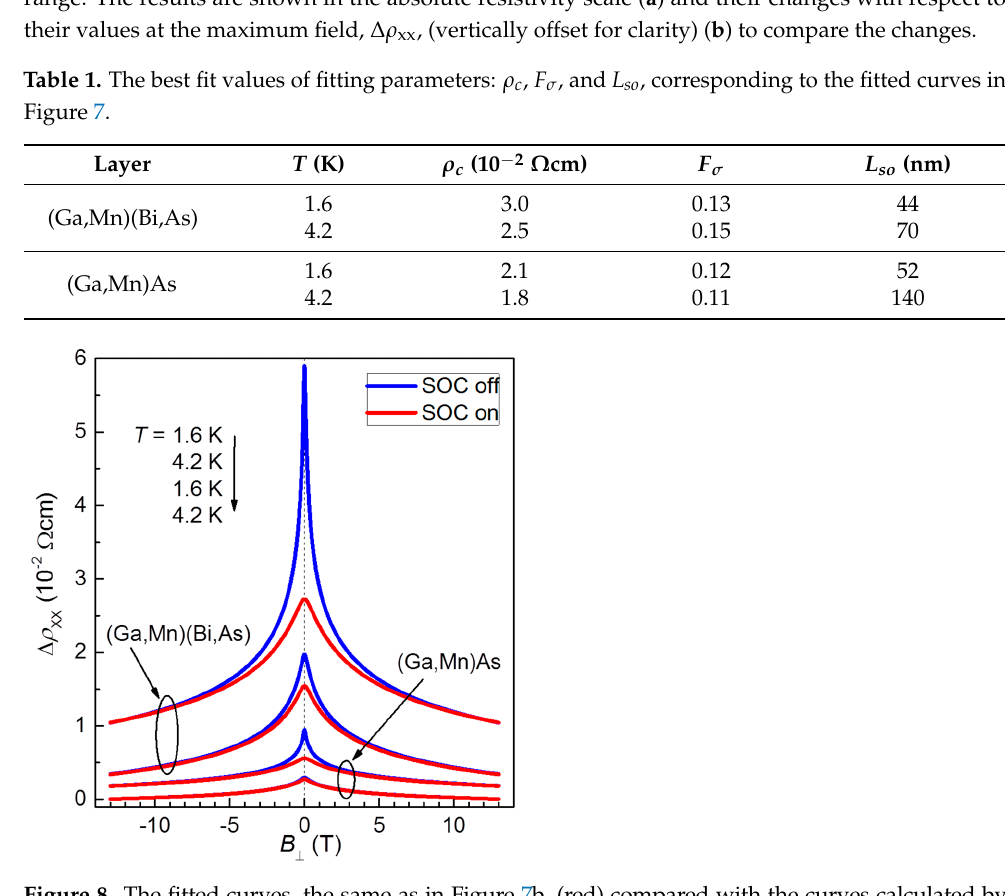
Figure 8. The fitted curves, the same as in Figure 7b, (red) compared with the curves calculated by Equation (3) (blue) with the spin–orbit interaction switched off, i.e., L so set as infinite ( B so = 0), and with the rest of parameters unchanged comparing the red curves. The curves are vertically offset for